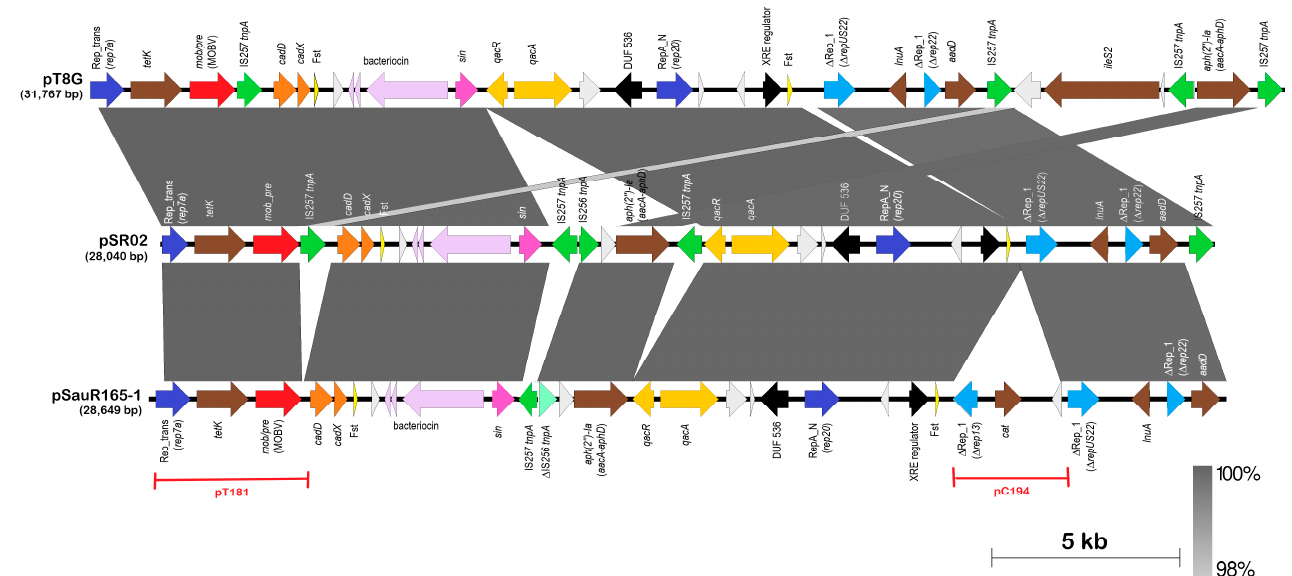
Figure 9. Comparative linear maps of the multidrug-resistant pSauR165-1 plasmid with its close relatives pSR02 plasmid from MRSA strain SR153 (accession no. CP048645; [119]) and pT8G from Staphylococcus lugdunensis strain Tlug8G-4 (accession no. KU882684.1; [120]). Arrows indicate the extent and direction of genes and open reading frames (ORFs). Antibiotic resistance genes are shown as brown-colored arrows, cadmium resistance genes ( cadDX ) in orange, and biocide/antiseptic resistance genes ( qacAR ) in gold. Full-length replication initiation (replicase) genes are depicted as dark blue arrows with partial or truncated rep genes labeled with the prefix “ ∆ ” and shown in lighter blue. Putative bacteriocin biosynthetic gene clusters are shown in light purple, whereas pink arrows are coding sequences for serine-recombinases, and red arrows are the mob/pre -mobilization genes. Insertion sequence (IS)-encoded transposases are depicted as green arrows, light yellow triangles indicate genes for the Fst-type I toxins, black arrows are ORFs with known domains, and ORFs encoding hypothetical proteins are depicted in light grey. Regions of pSauR165-1 that shared sequence identity with smaller plasmids are indicated in red lines labeled with the names of the respective homologous smaller plasmids. Grey-shaded areas show regions with >98% nucleotide sequence identities.